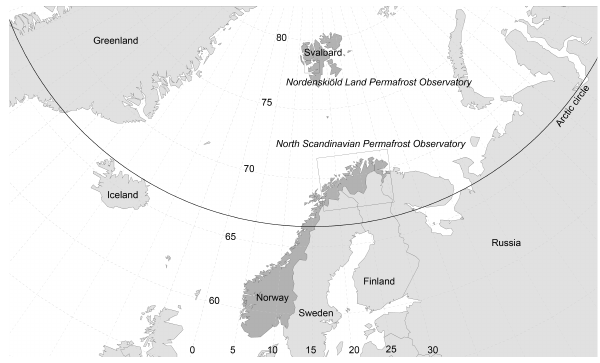
Figure 1. Location of the North Scandinavian Permafrost Observa- tory (cf. Fig. 2) and the Nordenski¨old Land Permafrost Observatory (cf. Fig. 3) in the North-Atlantic Region. The numbers indicate the latitude and longitude in degrees N and E, respectively.